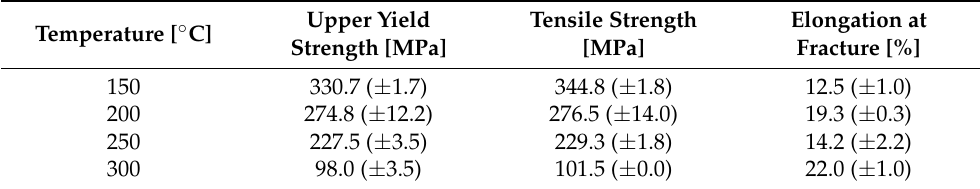
Table 6. High temperature mechanical properties of T7-treated Ti/B-2618 Al alloy. Temperature [ ◦